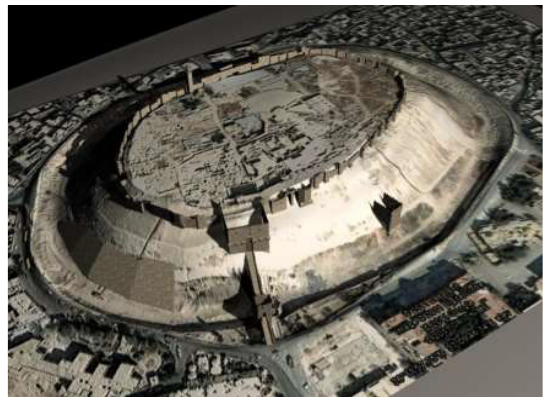
Figure 11. Documenting and modeling the Aleppo citadel with its walls. Courtesy: G. Fangi